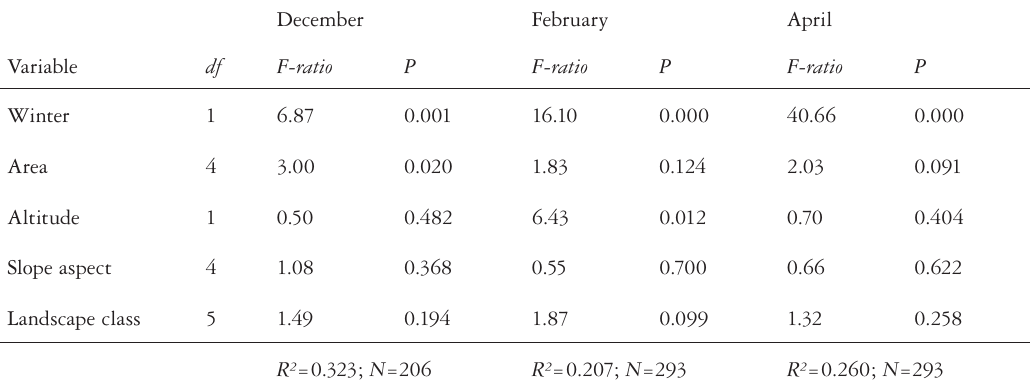
Table 3. Effect of different variables on snow hardness (g/cm²) in the hardest snow layer in the Ivalo reindeer herding district during three successive winters (1999 - 2002). Multivariate GLM.